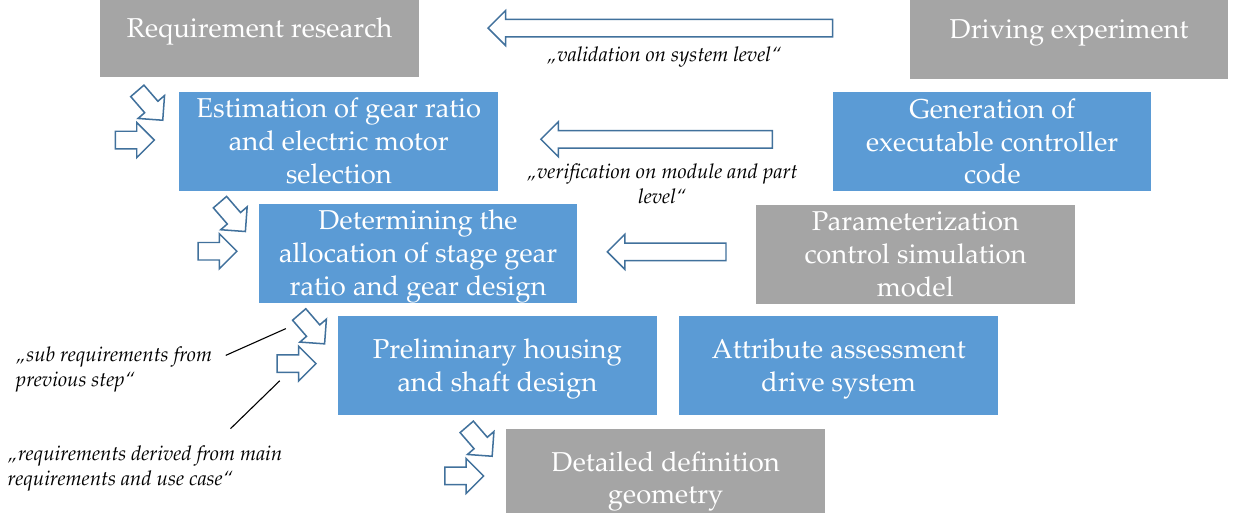
Figure 10. Process of drive train synthesis with